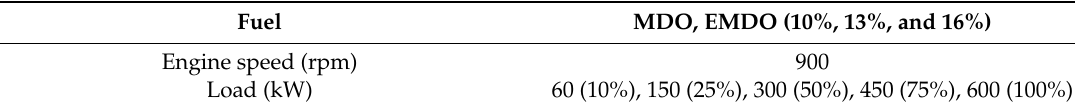
Table 3. Experimental condition.